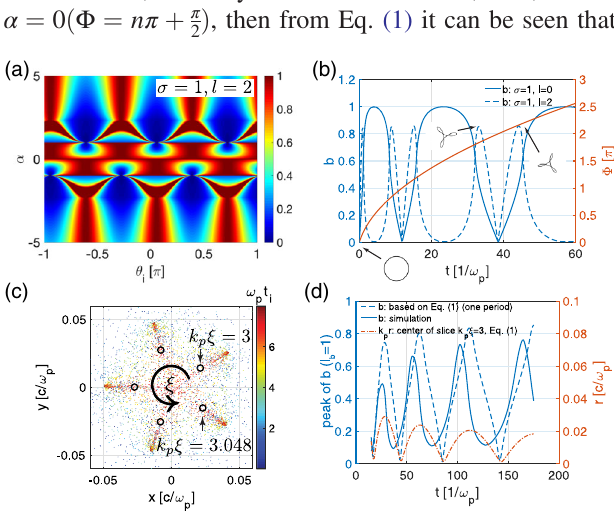
ð θ Þ FIG. 2. Theoretical analysis of the twisted structure. (a) g 2 ; 1 ξ ¼ 2 . 24 . The value at each α is normalized by 10 when with k p i 1 ≤ j α j < 2 and its maximum for other α . (b) The bunching factor ¼ l þ σ ) and the betatron phase of the electrons ( k ¼ 0 ; l b ¼ 0 . 1 ; a ¼ 0 . 1 ; k ξ ¼ 2 . 24 , and t ¼ 0 . r ionized with k p i i p i i (c) l ¼ 0 , σ ¼ 1 : the distribution of the electrons and their t ¼ 31 in five different slices using centers (black circles) at ω p Eq. (1). (d) The evolution of the peak of the bunching factor and ξ ¼ 3 the radial position of the center of the k p